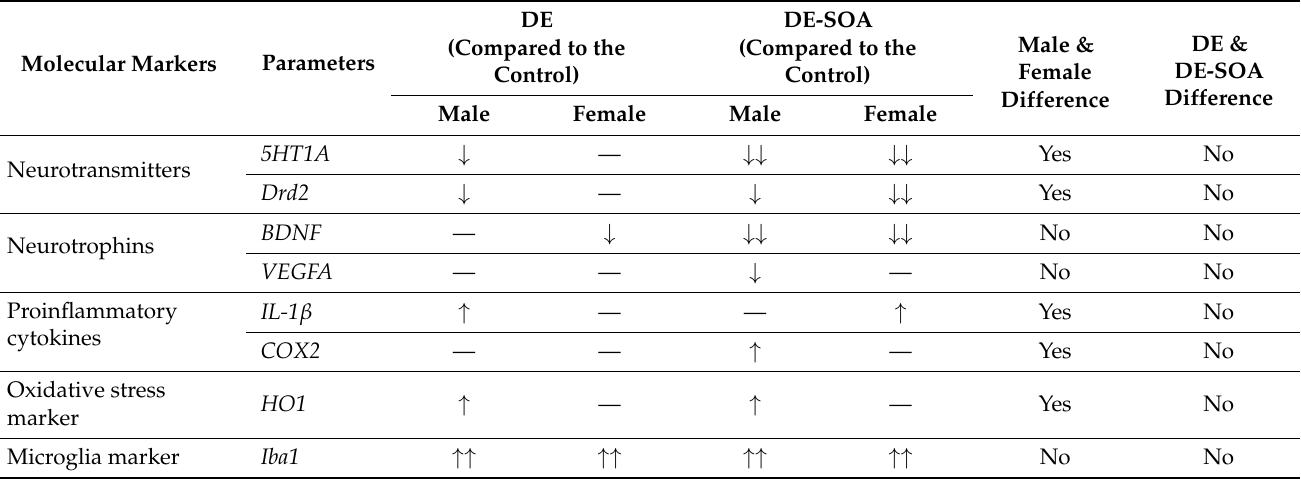
Table 2. Summarized results of comparison of expression of molecular markers between DE and DE-SOA in male and female